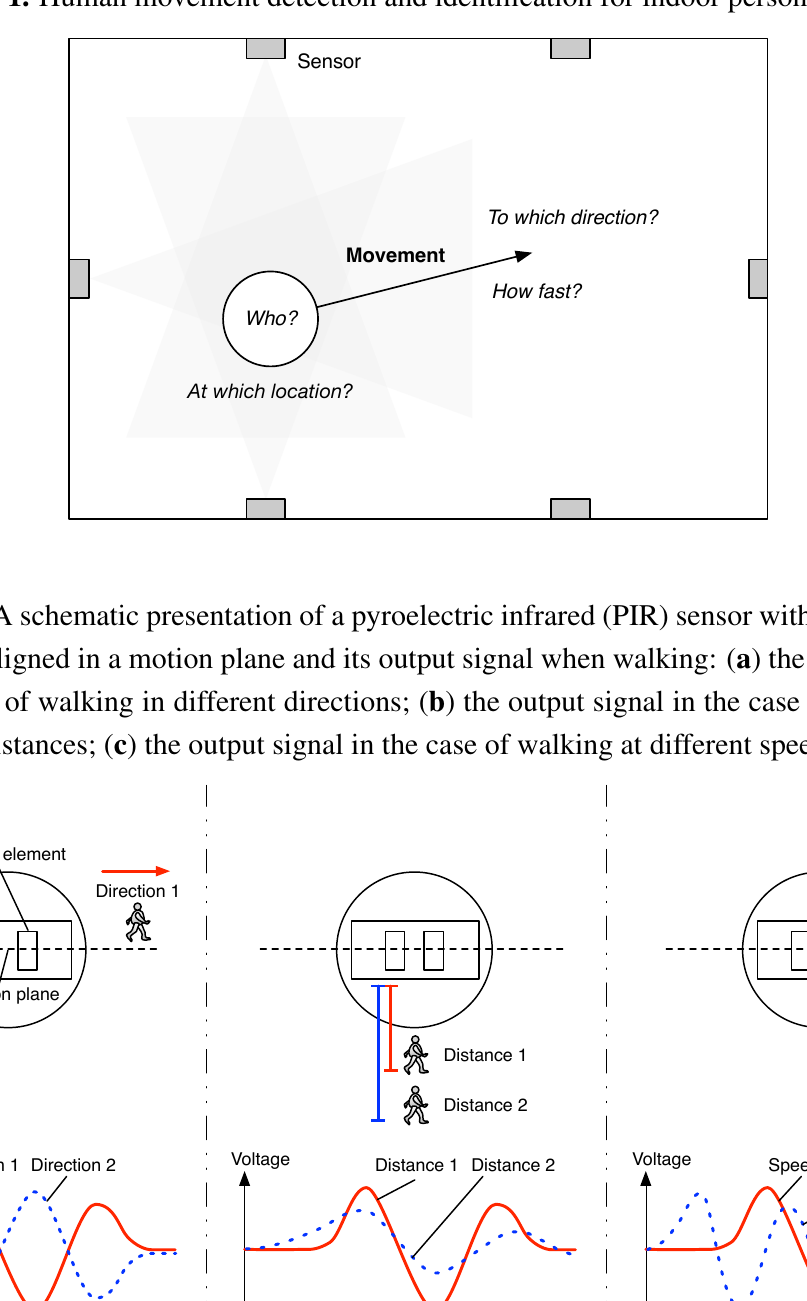
Figure 1. Human movement detection and identification for indoor person tracking.